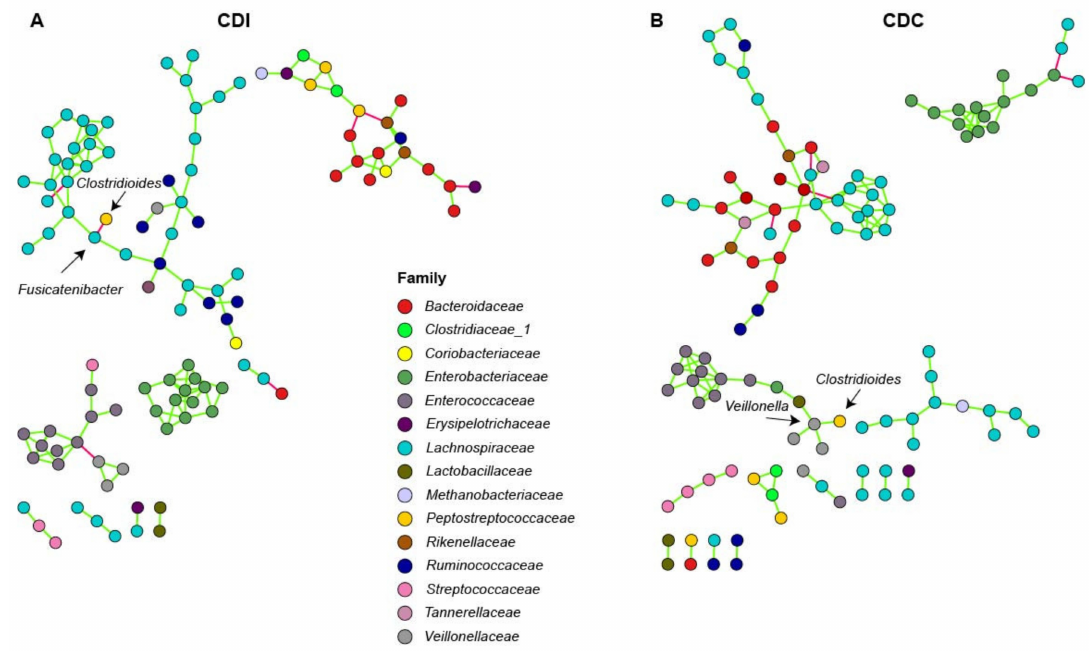
Figure 4. Association network analysis using SpiecEasi in CDI ( A ) and CDC ( B ) patients. Each node represents a single OTU and is colored according to family-level taxonomy. Green edges indicates a positive association between nodes, and red edges indicate a negative association between